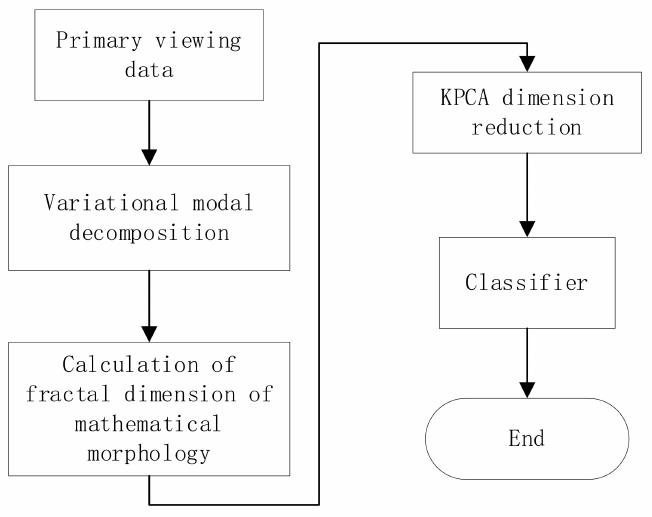
Figure 2. VMD‑MMFD Method Flow Chart.